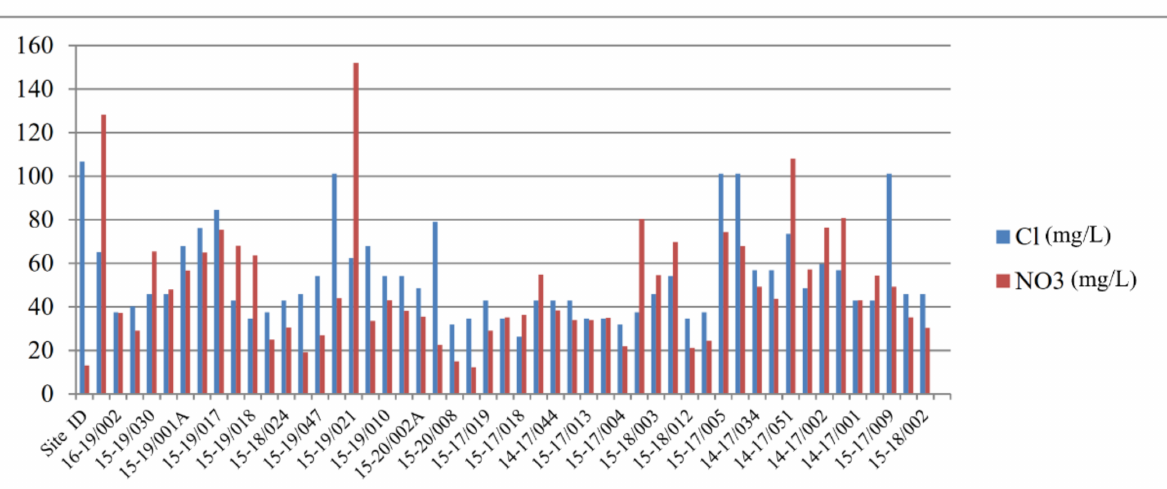
Figure 1. Annual average chloride and nitrate content in selected wells in Qalqilia and Tulkarm in the West Bank 2013